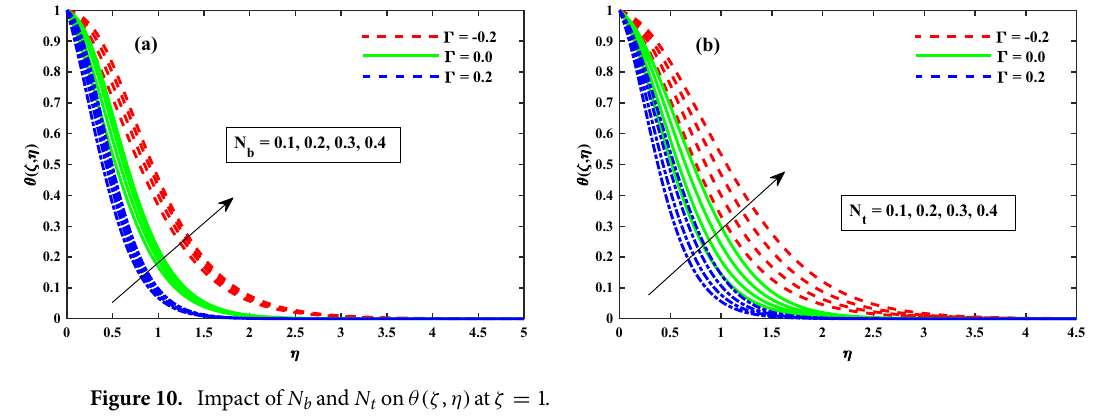
Figure 10. Impact of N b and N t on θ(ζ , η) at ζ